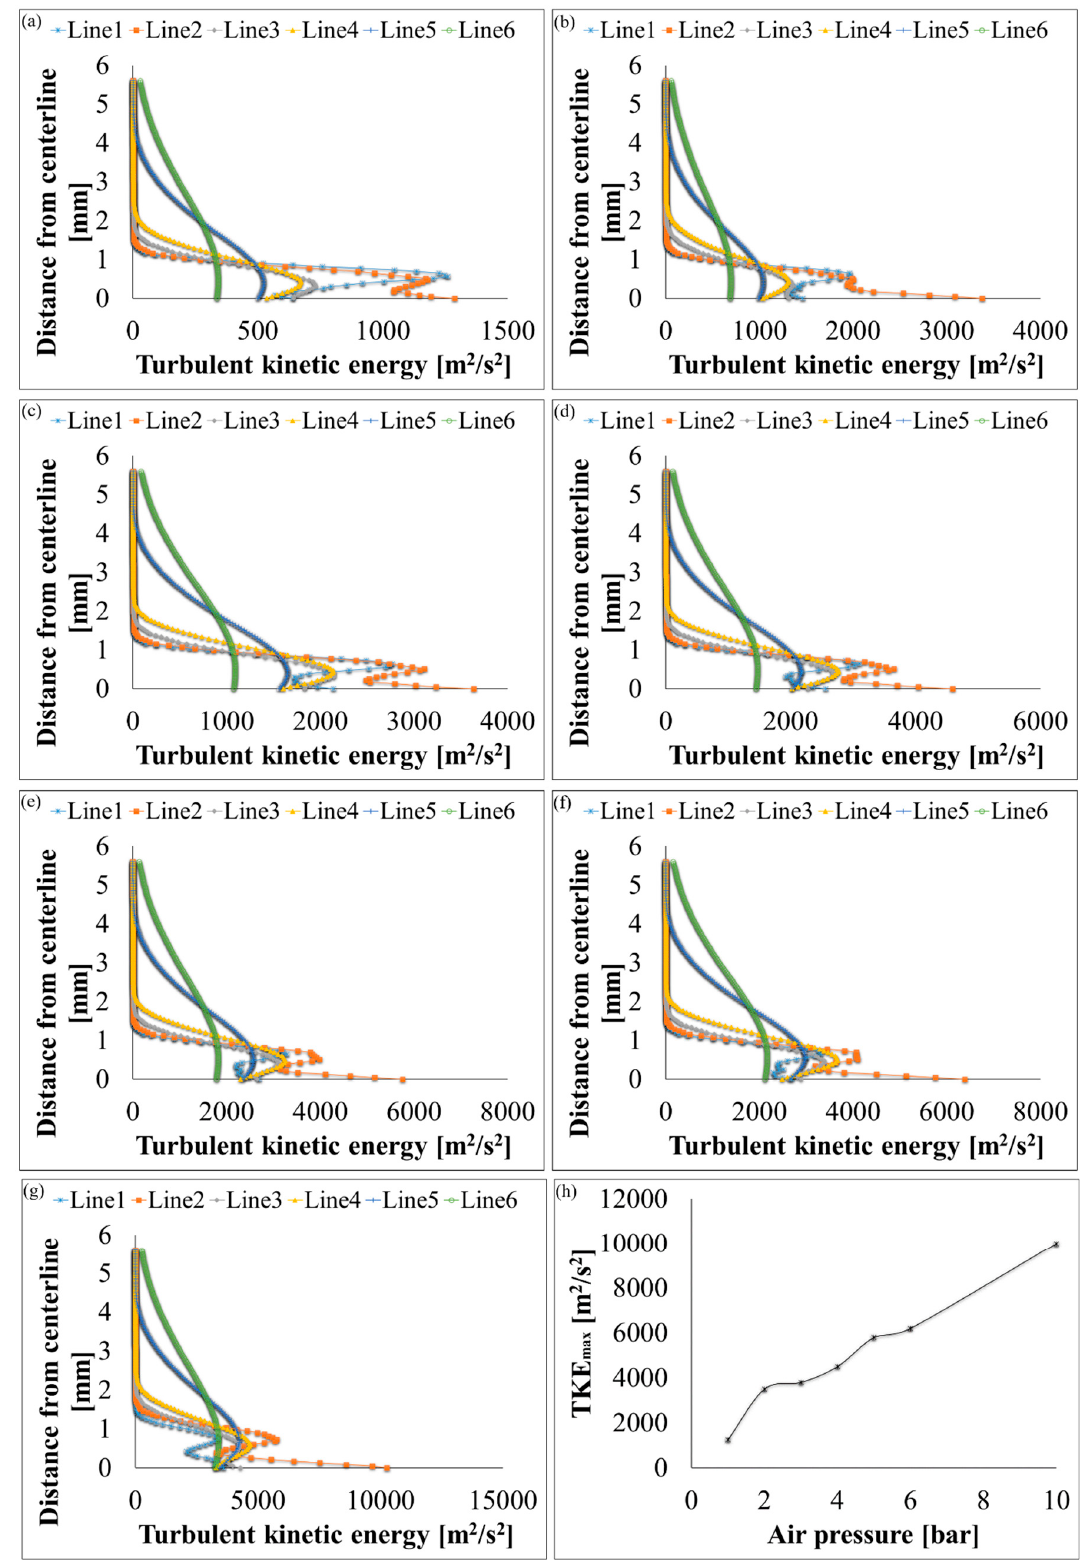
Figure 11. Turbulent kinetic energy profiles at six vertical slices (at distance of 0, 1, 4, 6, 16, and 26 mm from the air outlet) for k- ε turbulence flow plots through SBS nozzle at different air pressures: ( a ) 1 bar, ( b ) 2 bar, ( c ) 3 bar, ( d ) 4 bar, ( e ) 5 bar, ( f ) 6 bar, ( g ) 10 bar, and ( h ) maximum turbulent kinetic energy values at different air pressures.